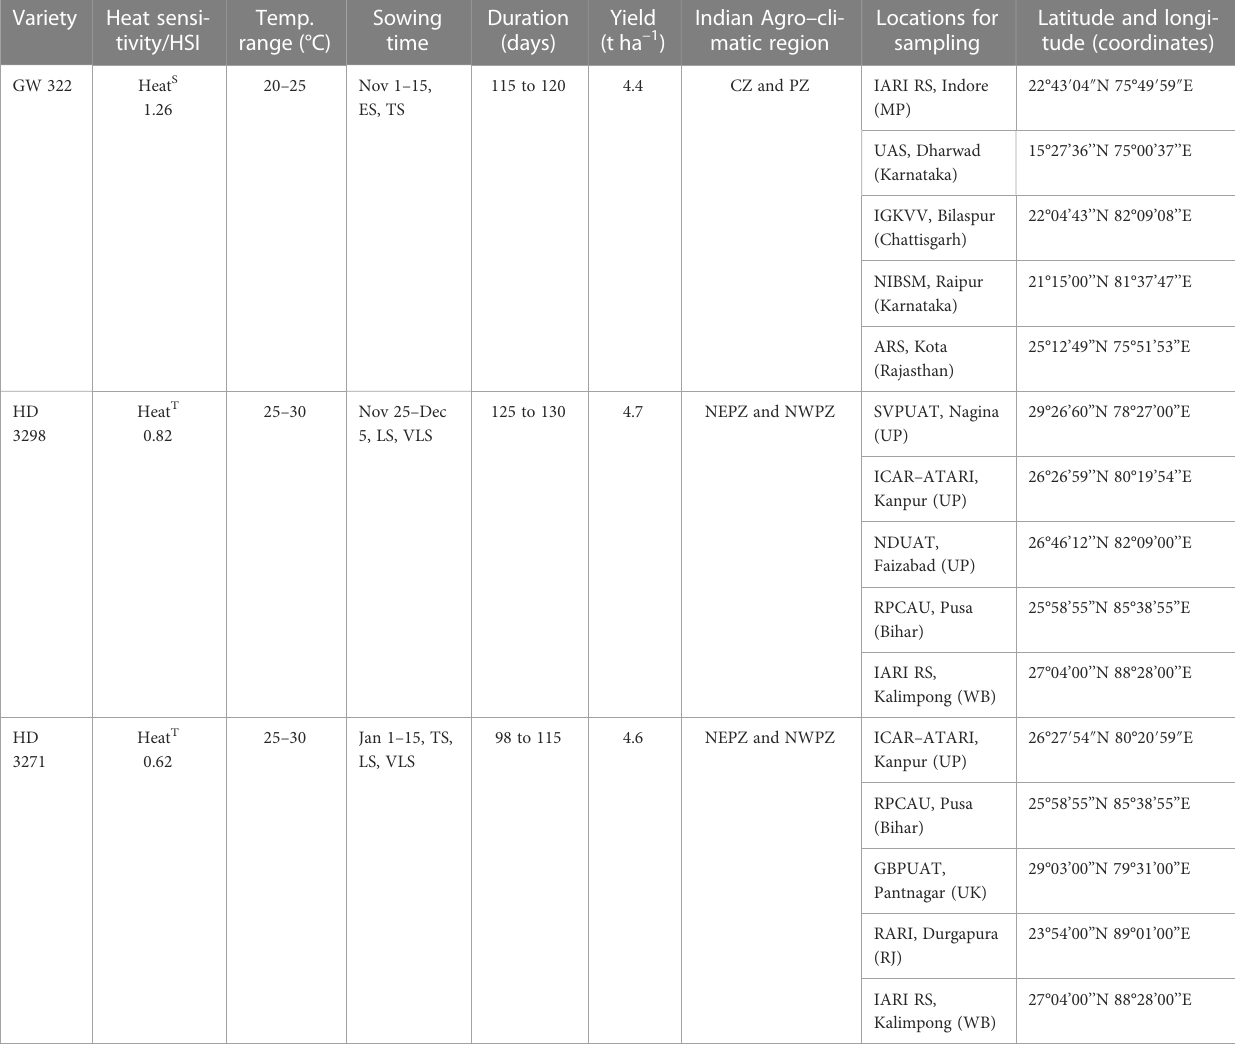
TABLE 1 General features of wheat varieties*.